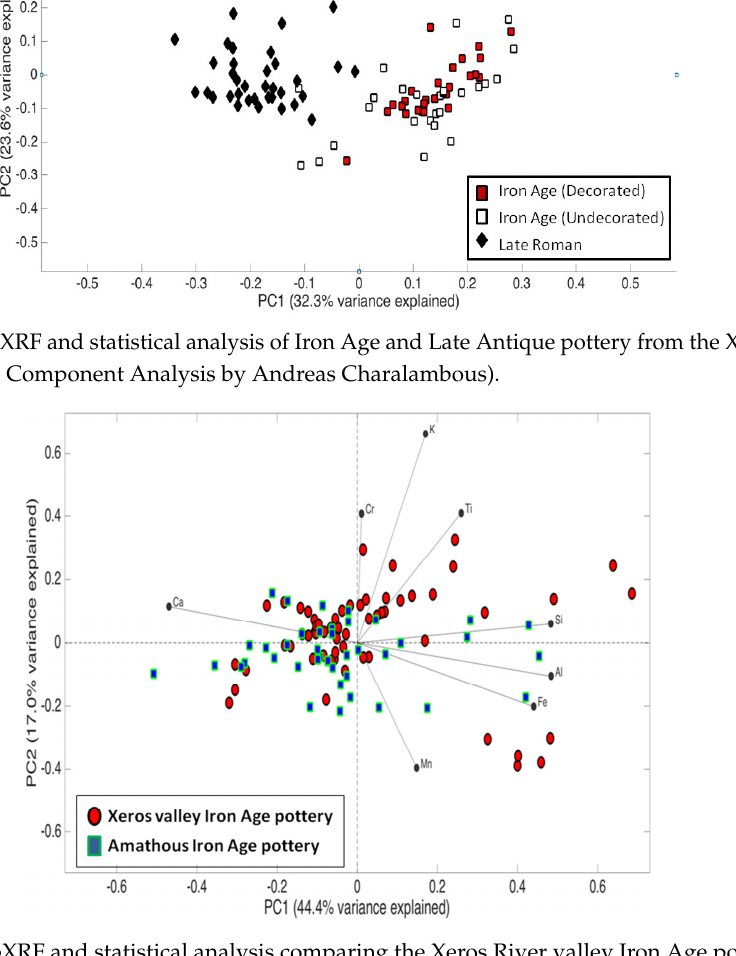
Figure 19. The pXRF and statistical analysis comparing the Xeros River valley Iron Age pottery with pottery from the palace of Amathous (Principal Component Analysis by Andreas